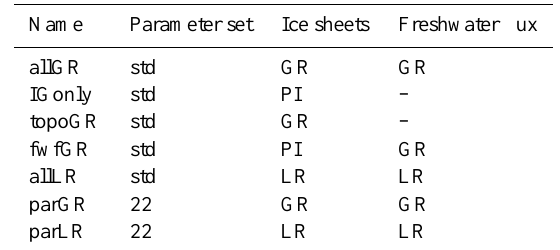
Table 1. Description of the transient simulations. All the simula- tions are forced by changes in insolation and atmospheric GHG concentrations (see text). The reference parameter set (std) is de- fined and used in Goosse et al. (2010), while parameter set 22 is defined and used in Loutre et al. (2011) and Goosse et al. (2007) (see also supplementary material). PI stands for pre-industrial; GR (respectively LR) means that the LIG ice sheet configuration and/or freshwater flux is reconstructed based on Grant et al. (2012) (re- spectively, Lisiecki and Raymo,